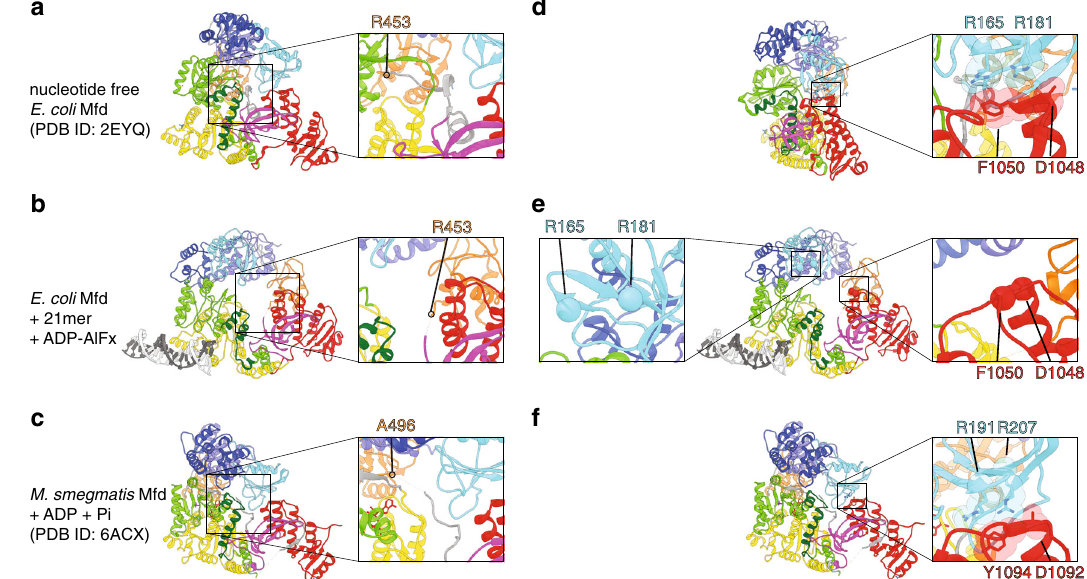
Fig. 4 DNA binding unmasks the UvrA recruitment surface within domain D2 of Mfd. a – c Top view of nucleotide-free E. coli Mfd a , E. coli Mfd complexed to DNA and ADP-AlF x b and M. smegmatis Mfd bound to ADP and Pi c (PDB ID 6AXC). Insets show the D3 – D4 linker, and C-terminal residues in D3 as positional markers. The D3 – D4 linker is not visible in our map of DNA-bound Mfd b or in M. smegmatis Mfd c . d – f Overall views of Mfd with insets highlighting the disruption of the D2 – D7 interaction upon DNA binding. Amino acids involved in domain – domain interactions (R165, R181, D1048, F1050) are shown as CPK with stick models. Middle inset highlights the unmasking of R165 and R181 (spheres), important for UvrA recruitment. In all panels, Mfd is colored by domain as in Fig. 2a.